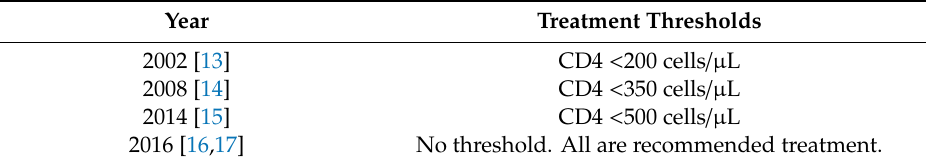
The thresholds for initiating antiretroviral therapy over time in Chinese national treatment